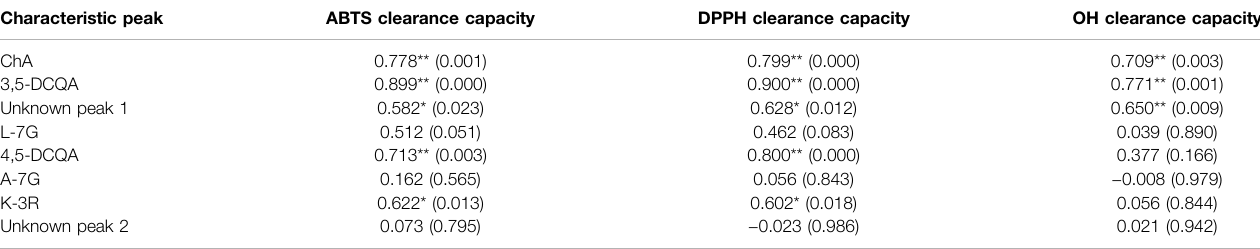
The data means the correlation coef fi cient ( p value).